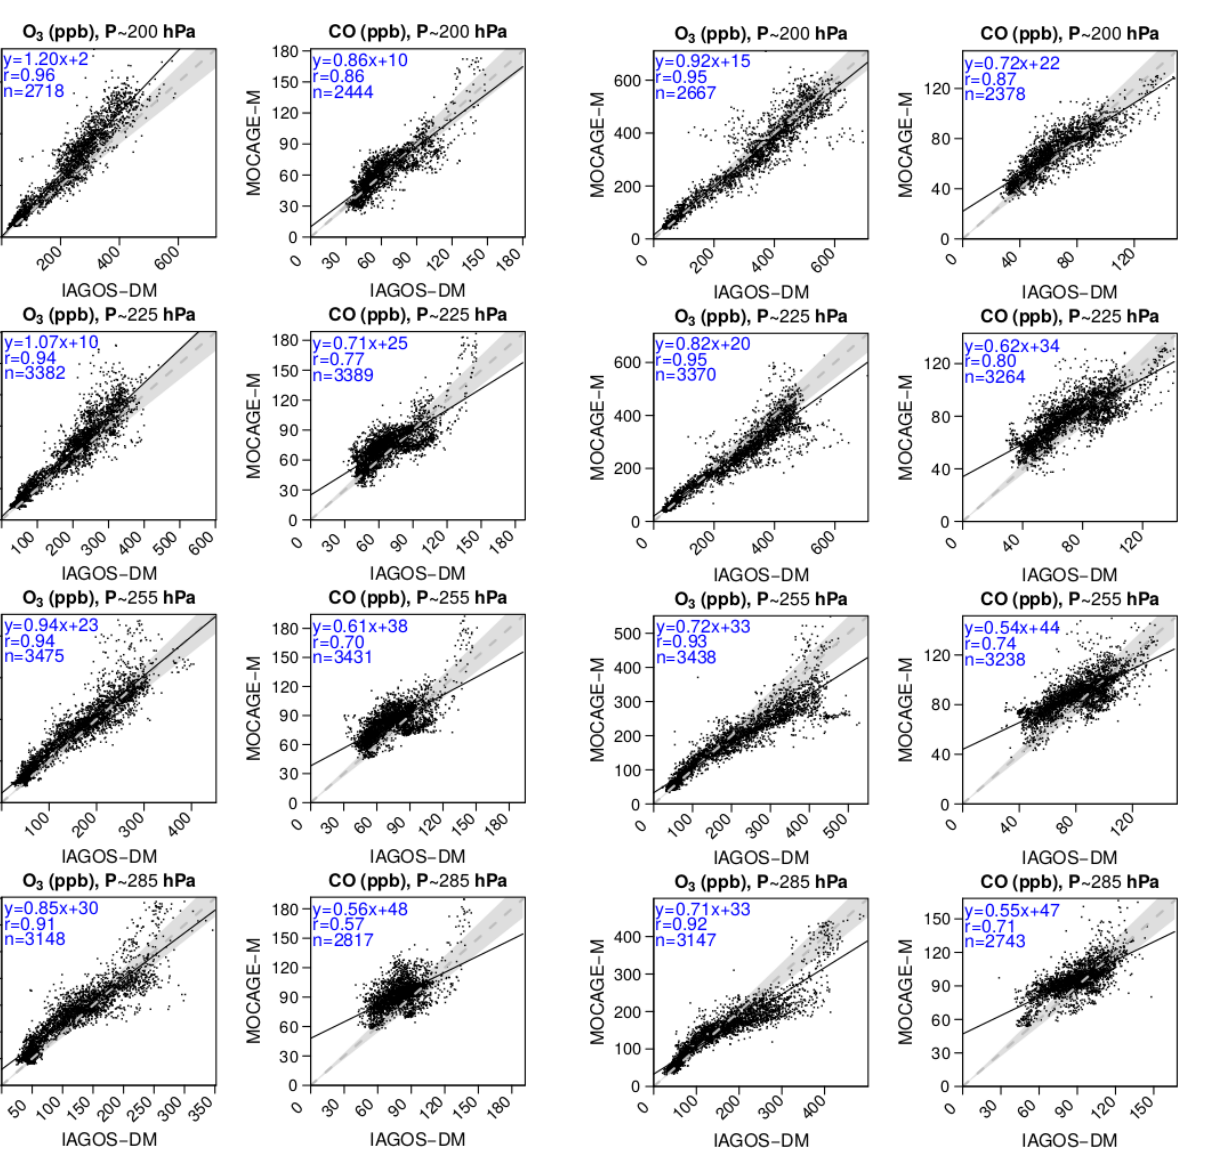
Figure B1. As Fig. 5 for boreal winter. Figure B2. As Fig. 5 for boreal